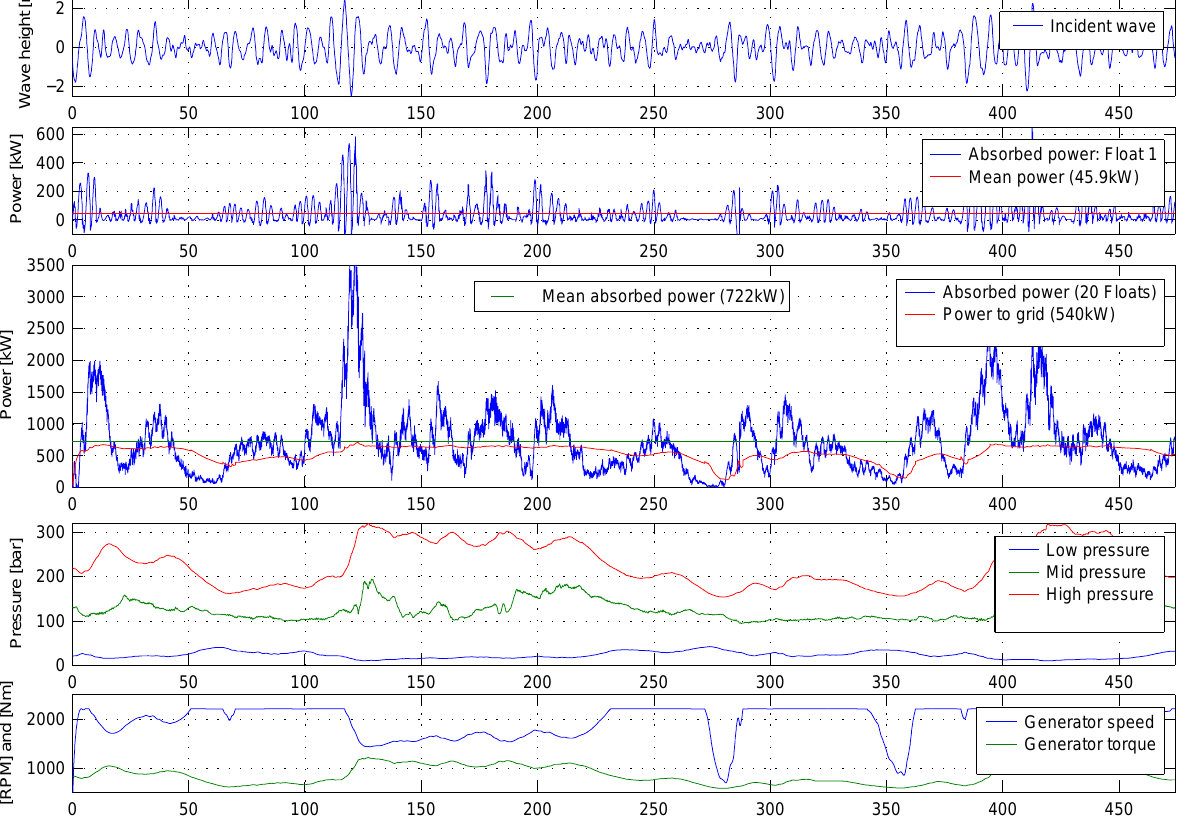
Figure 27. PTO simulation results for Wavestar C5 for sea state 3, H